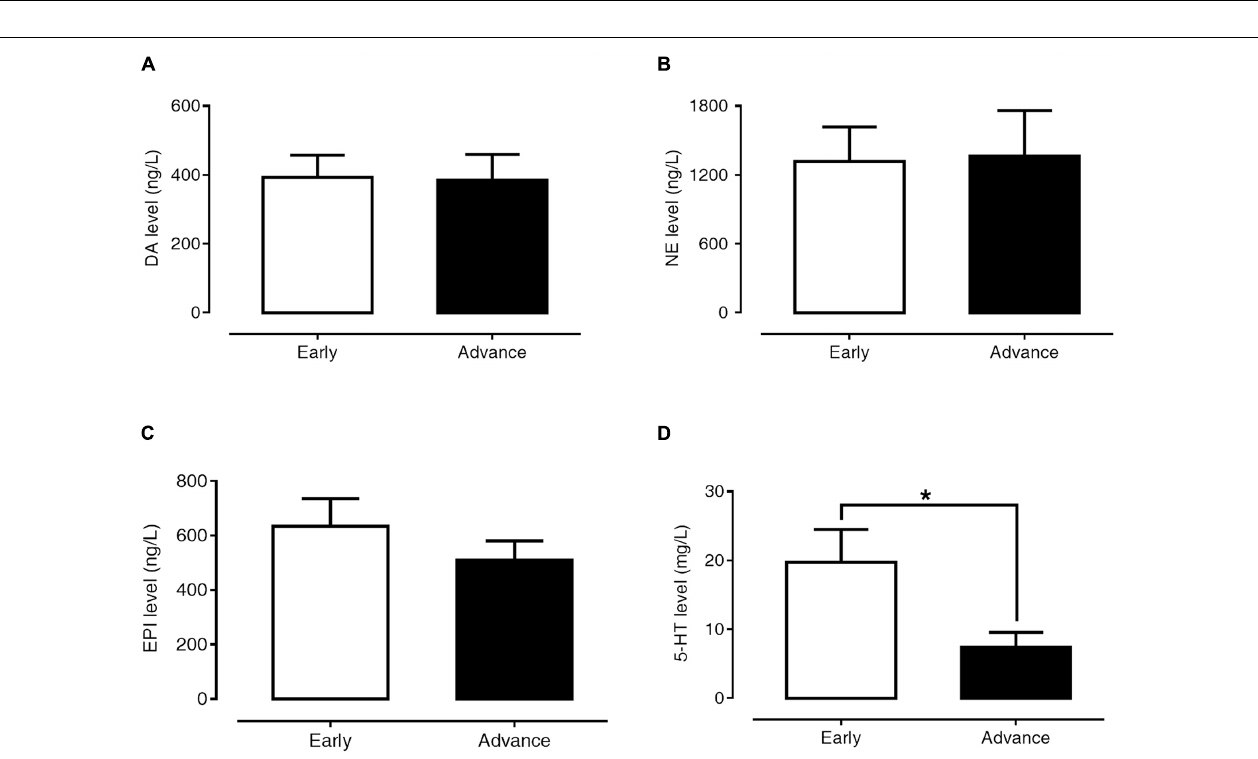
FIGURE 4 | Levels of plasma DA (A) , NE (B) , EPI (C) , and 5-HT (D) in early- and advanced-stage PD patients. Data are presented as mean ± SEM (* p < 0.05).